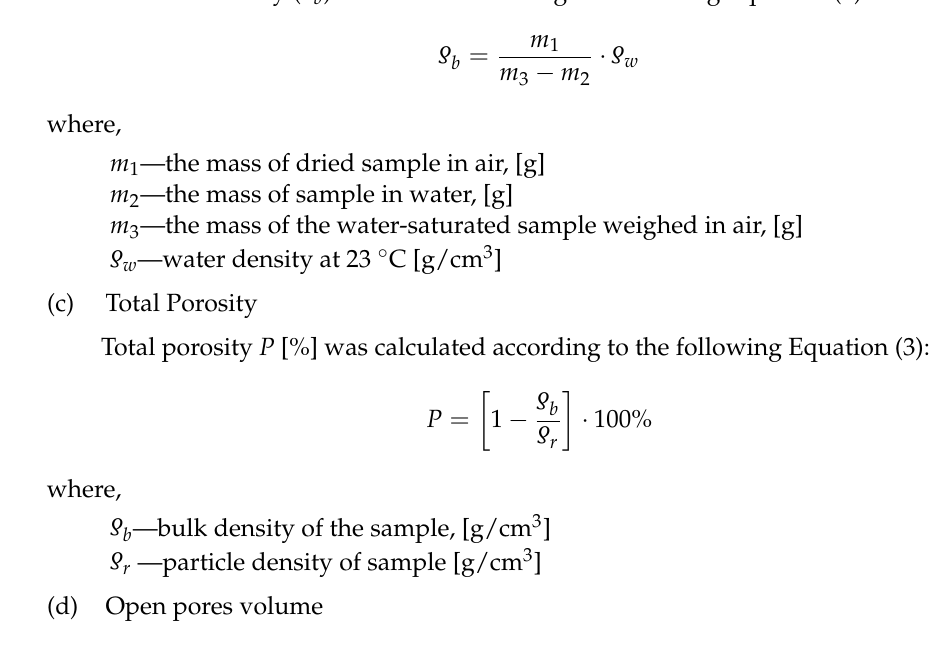
Figure 3. Slump flow test.